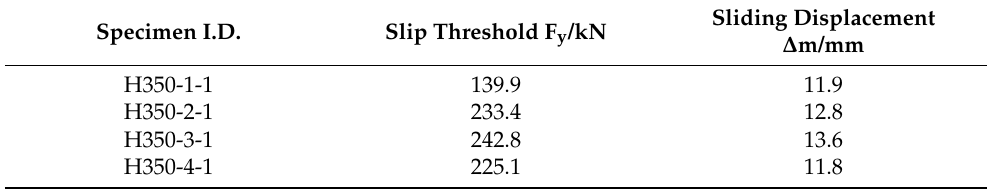
Figure 14. Force − displacement skeleton curves. Table 5. Force and displacement at characteristic points of the skeleton curves. Specimen I.D.